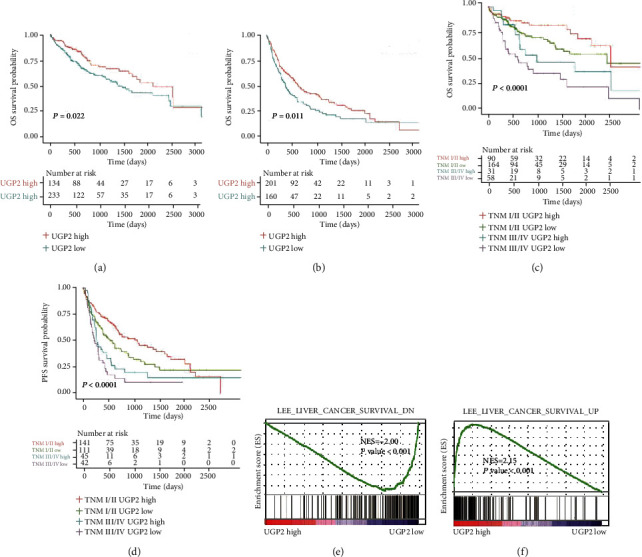
Downregulated UGP2 expression predicts a poor prognosis in HCC patients in the TCGA cohort. (a, b) Kaplan-Meier survival curves showing the correlation between UGP2 expression levels and the OS/PFS of HCC patients in the TCGA cohort. (c, d) Kaplan-Meier analysis showed that OS/PFS was shorter in HCC patients in the TCGA cohort with low UGP2 expression levels regardless of the TNM stage. (e, f) GSEA of the relationship between low UGP2 expression levels and the survival of HCC patients in the TCGA cohort. UGP2: uridine diphosphate-glucose pyrophosphorylase 2; TCGA: The Cancer Genome Atlas; HCC: hepatocellular carcinoma; OS: overall survival; PFS: progression-free survival; HCC: hepatocellular carcinoma.